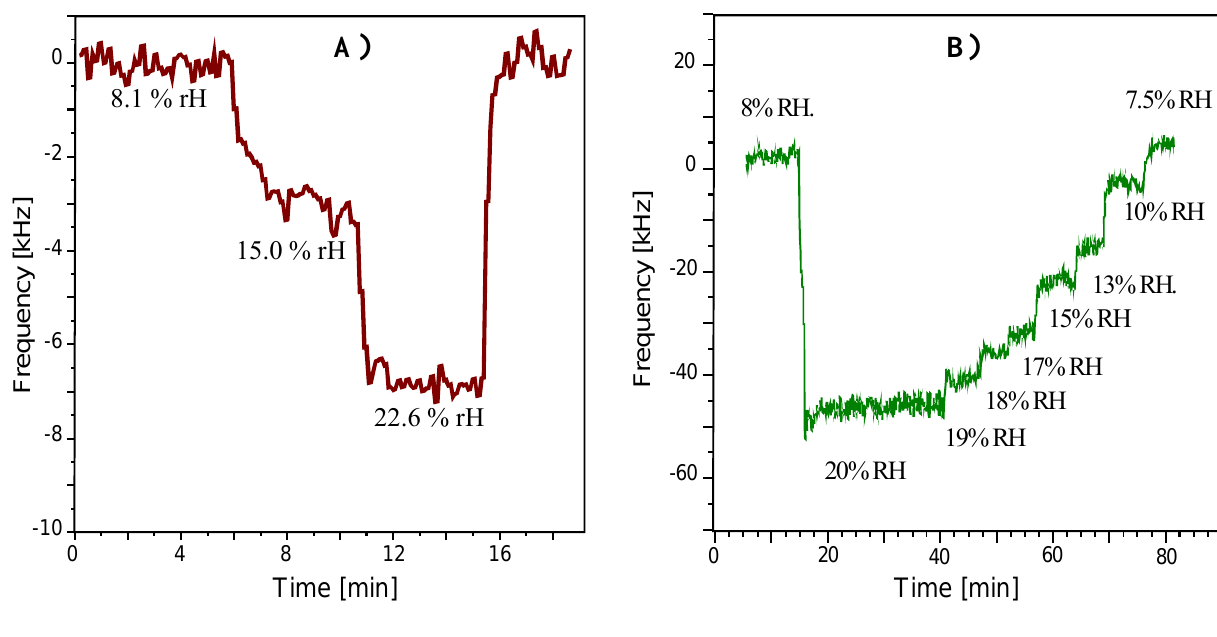
Figure 7. (a) Sensor response (frequency shifts at a distinct attenuation) of the uncoated RFID-Tag to varying amounts of humidity (T = 20 °C, flow: 1 L/min); (b) Sensor response (frequency shifts at a distinct attenuation) of the PVA coated RFID-Tag to varying amounts of